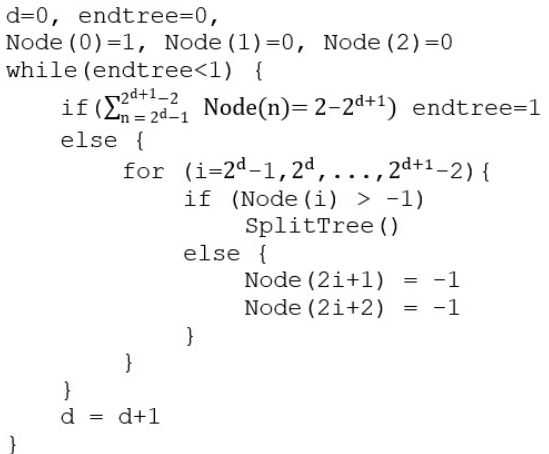
Figure 5. CART pseudocode. Figure 5. CART